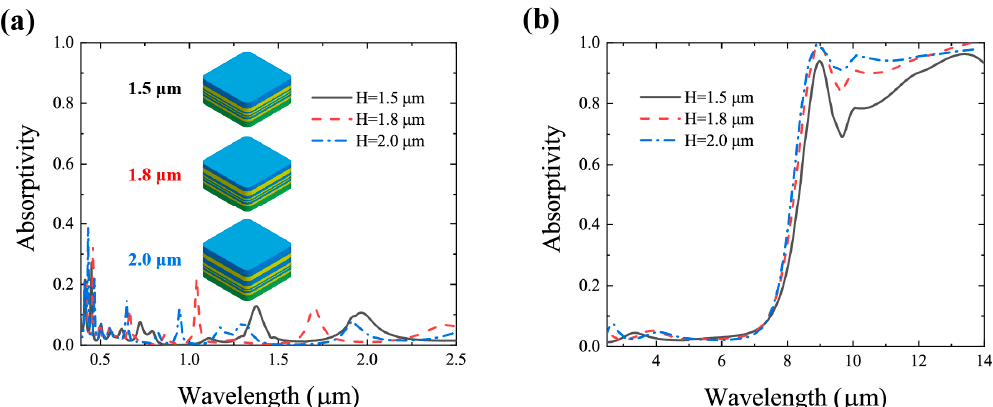
Figure 6. Simulated absorptivity of coatings with same materials composition, but different total